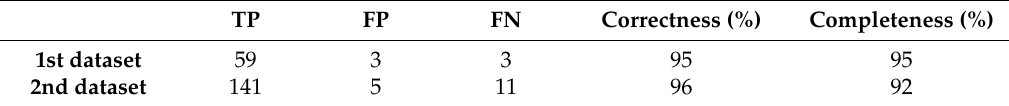
Table 2. Correctness and Completeness of Window detection via Our Method.